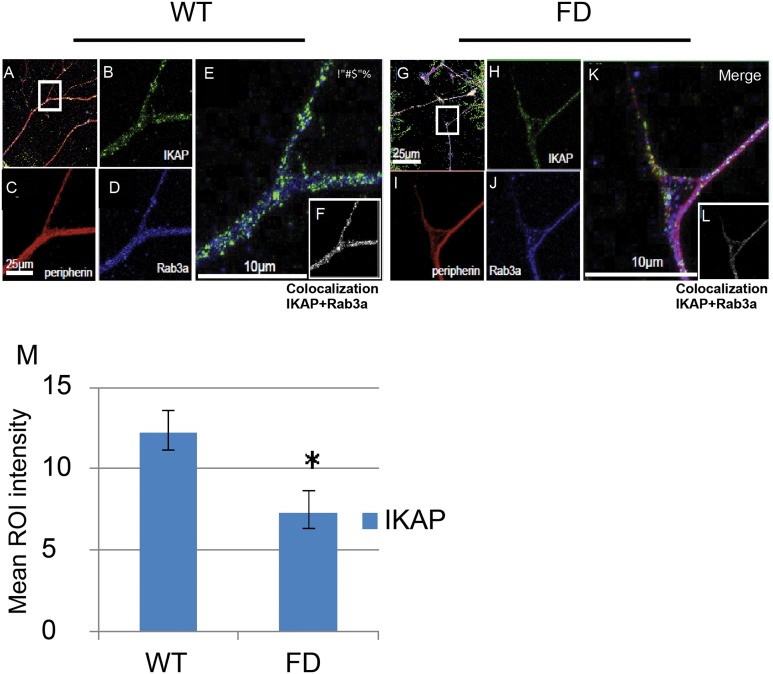
Characterization of IKAP localization in PNS WT and FD hESC-derived cultured neurons.Immunofluorescence confocal microscopy analysis was performed as shown in Fig 3. IKAP together with peripherin and Rab3a expression are shown within hESC derived neurons in WT (A-F) and FD (G-L) genetic backgrounds. Images B and H show the expression and localization of IKAP in WT and FD derived-neurons respectively. C and I, D and J show the expression of peripherin and Rab3a respectively. IKAP and Rab3a co-localization levels are shown in WT (F) and FD (L). Quantitative analysis of the mean intensity of IKAP and RAB3a colocalization levels in WT and FD axons is shown in M. 3D stacks of sequential confocal images were de-convolved using Huygens (scientific volume imaging-SVI) software and the analyzed for colocalization between the signals was performed using Imaris (Bitplan). Bar sizes are indicated in representative images. Mouse anti-hIKAP (BD Biosciences) was used in these experiments.